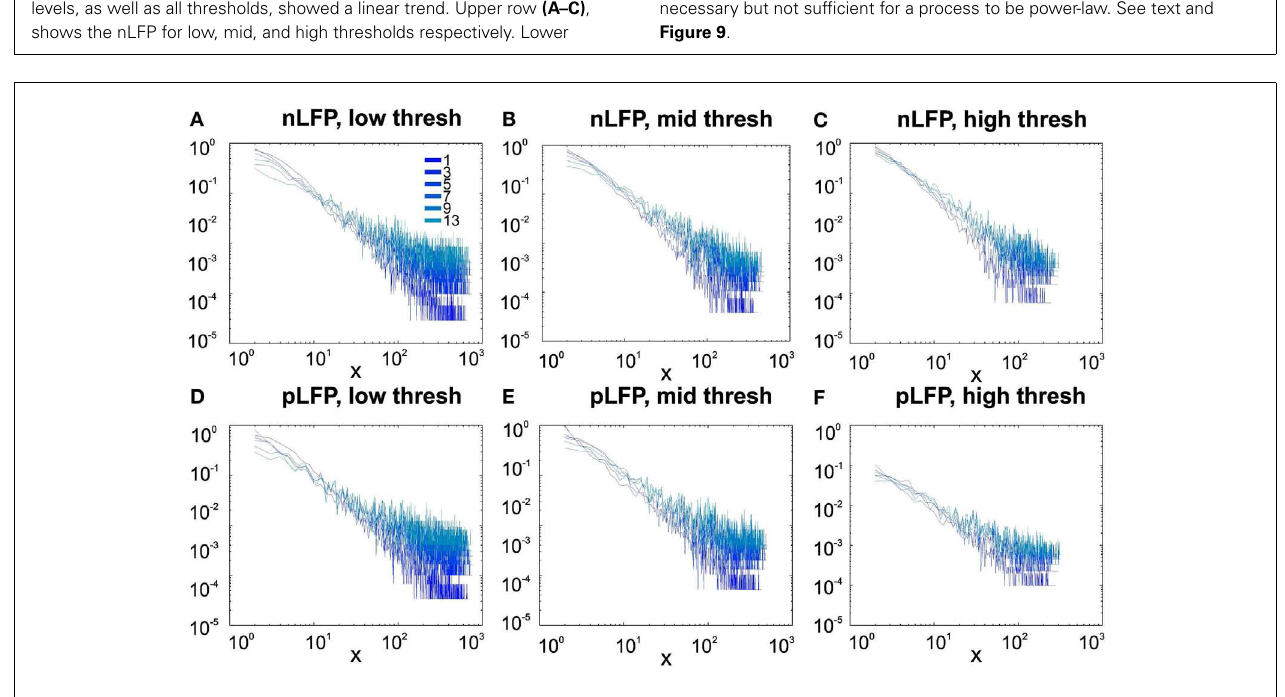
row (D–F) , shows the same for pLFP. Please notice that bin sizes 11 and 15 are not shown because for the clarity in the line plot; however, they too, also showed a very clear linear trend in this scale. Such trend is necessary but not sufficient for a process to be power-law. See text